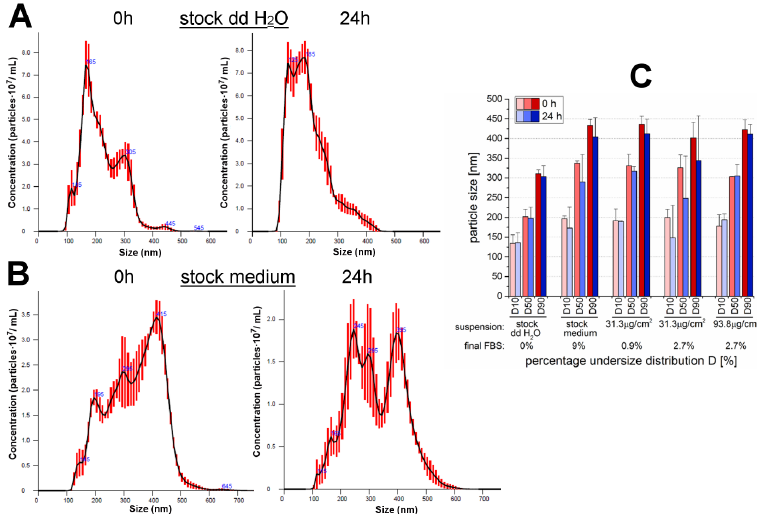
Figure 1. Influence of the suspension medium and the fetal bovine serum (FBS) amount on size distribution of 12 nm SiO 2 NPs analyzed by nanoparticle tracking analysis after 0 h and 24 h of incubation. Depicted are exemplary particle size distribution profiles (mean ± SEM of five measurements) of 1 mg/mL particle stock suspensions in ( A ) double-distilled water (FBS-free) or ( B ) 9% FBS-containing RPMI 1640 cell culture medium. Please mind the varying ordinate scaling; ( C ) Represented are D10, D50 and D90 values of the particle stock suspensions (1 mg/mL) suspended in either double-distilled water or RPMI 1640 cell culture medium, as well as, the medium incubation suspensions with area concentrations of 31.3 and 93.8 µ g/cm 2 . The final FBS amount varied. The D values indicate percentage undersize distribution, for example D10 indicates 10% particles are smaller than the D10 value. This gives indication of the distribution of particle sizes and their corresponding merged particle diameter in [nm] ( n ≥